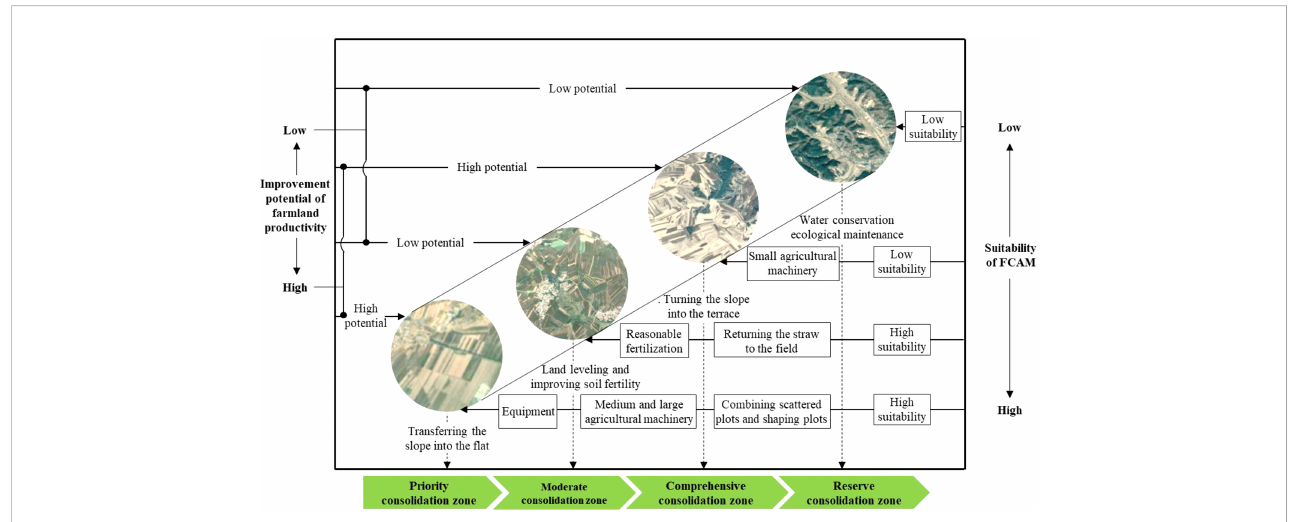
FIGURE 7 A zoning-based implementing mechanism of FCAM schemes. FCAM, farmland consolidation suitable for agricultural